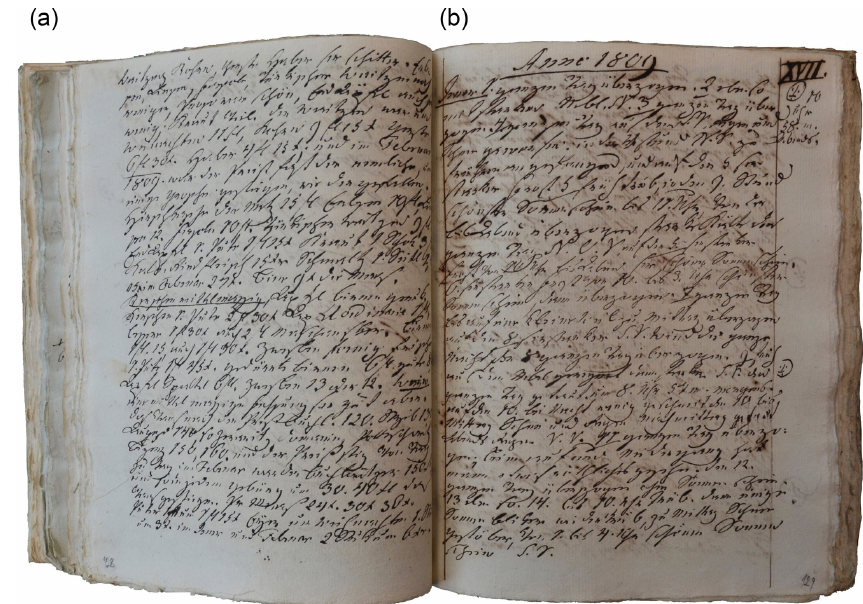
Figure 2. Example of pages from Hausner’s weather diary, with records from the end of 1808 (a) and the beginning of 1809 (b)